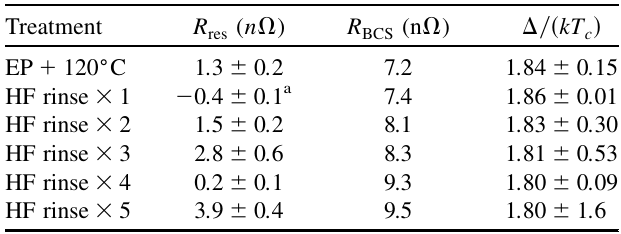
TABLE II. Changes in the superconducting properties after HF rinsing cycles for the bulk EP tumbled cavity TE1ACC002. Shown errors include standard deviation of the fit